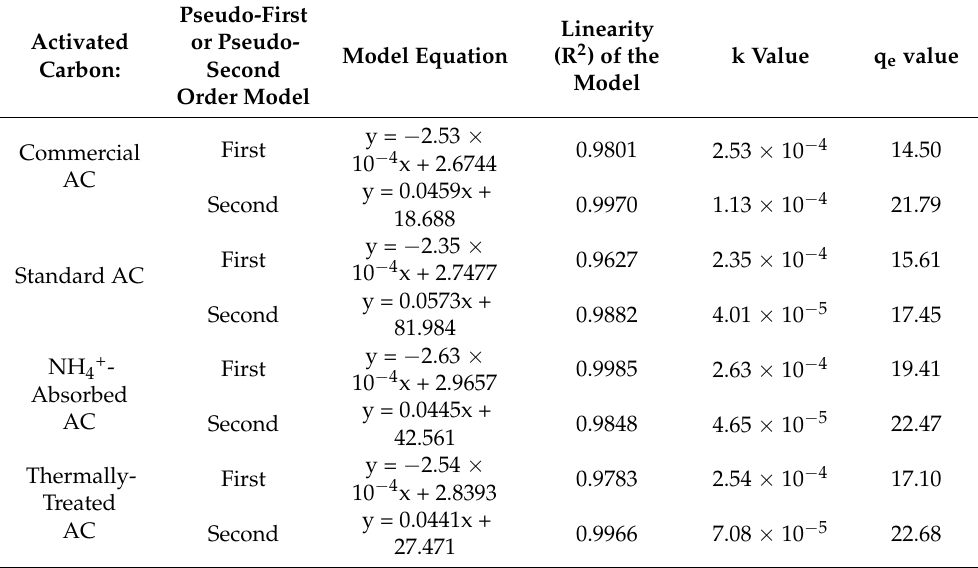
Table 4. A summary of the pseudo-first and pseudo-second-order kinetic modeling for each of the activated carbons that underwent kinetics